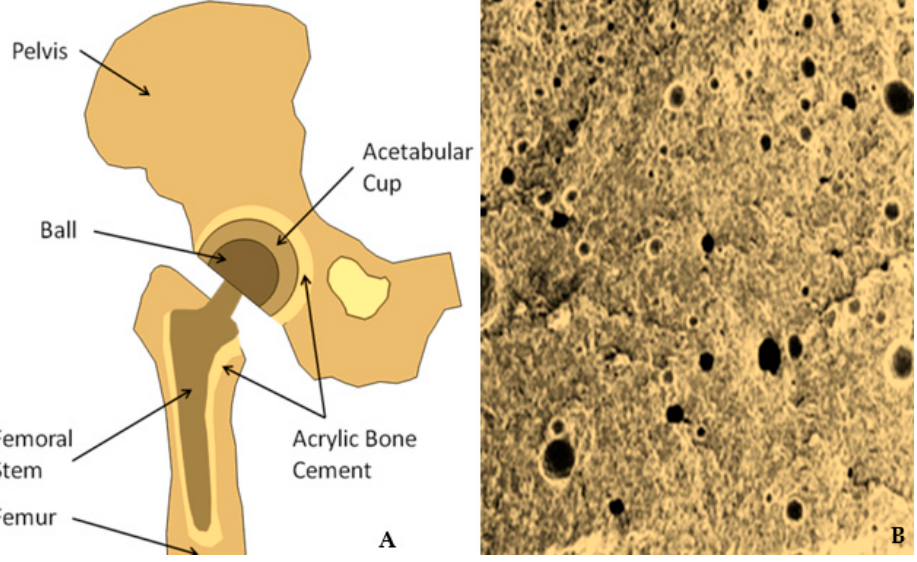
Figure 1. Schematic representation of CHP ( A ) and the cement’s electron microscopic aspect ( B ) .